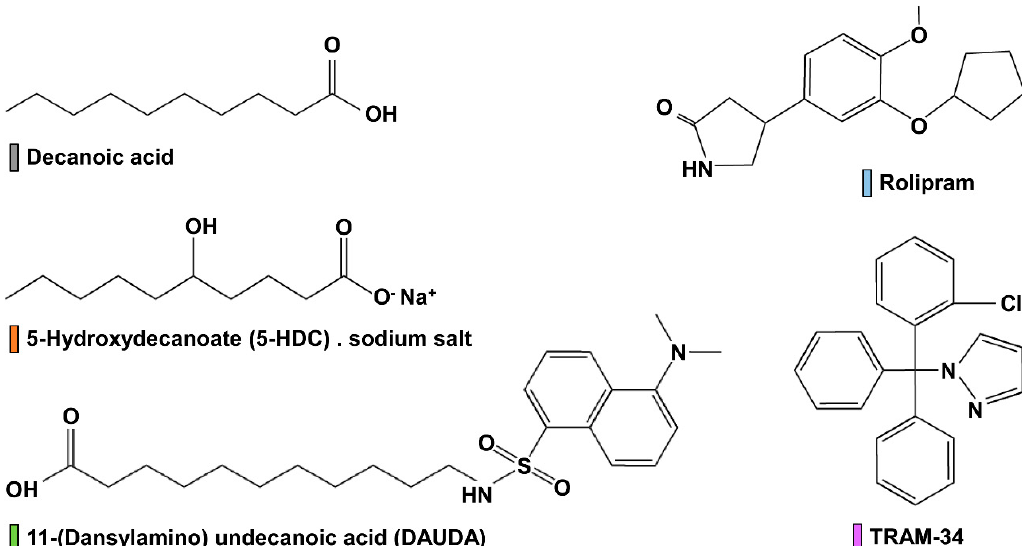
Figure 1. Chemical structures of commercially available compounds. Colored bars next to each compound name match the corresponding symbol color in the Figures.